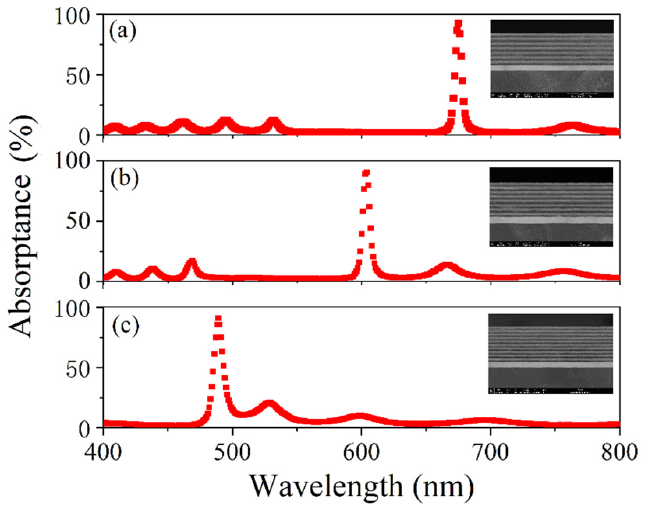
Figure 10. Measured absorption spectra of (BA) N MS. SEM images shown in the inset figures. ( a ) (BA) 7 MS. ( b ) (BA) 8 MS. ( c ) (BA) 10 MS.